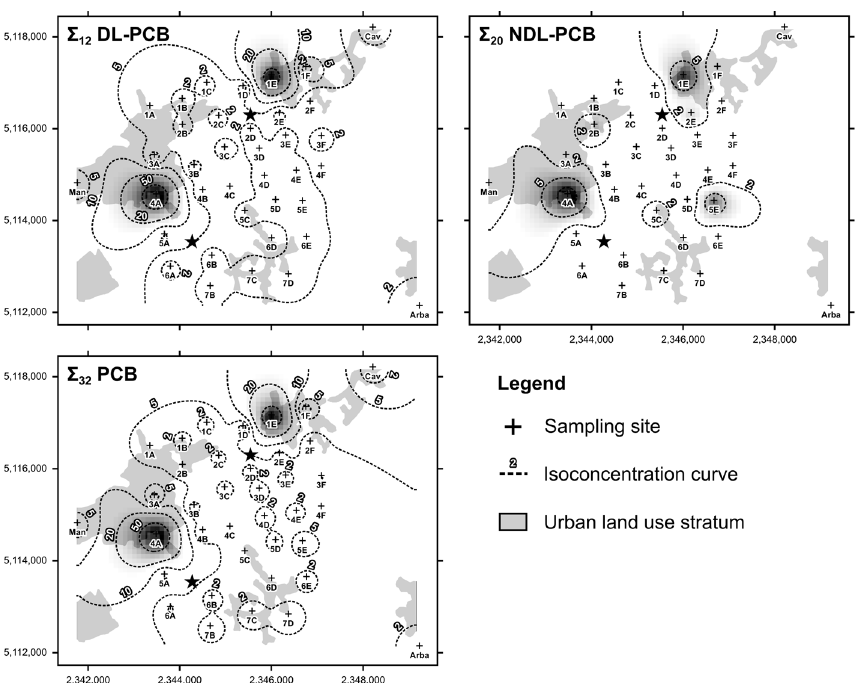
Figure 4. Distribution patterns of the concentration sums of the 12 dioxin-like ( Σ 12 DL-PCB), 20 non-dioxin-like ( Σ 20 NDL-PCB), and all 32 PCB congeners ( Σ 32 PCB) measured in the Robinia pseudoacacia leaf samples shown in Figure 1. For a list of measured PCBs, see the text.